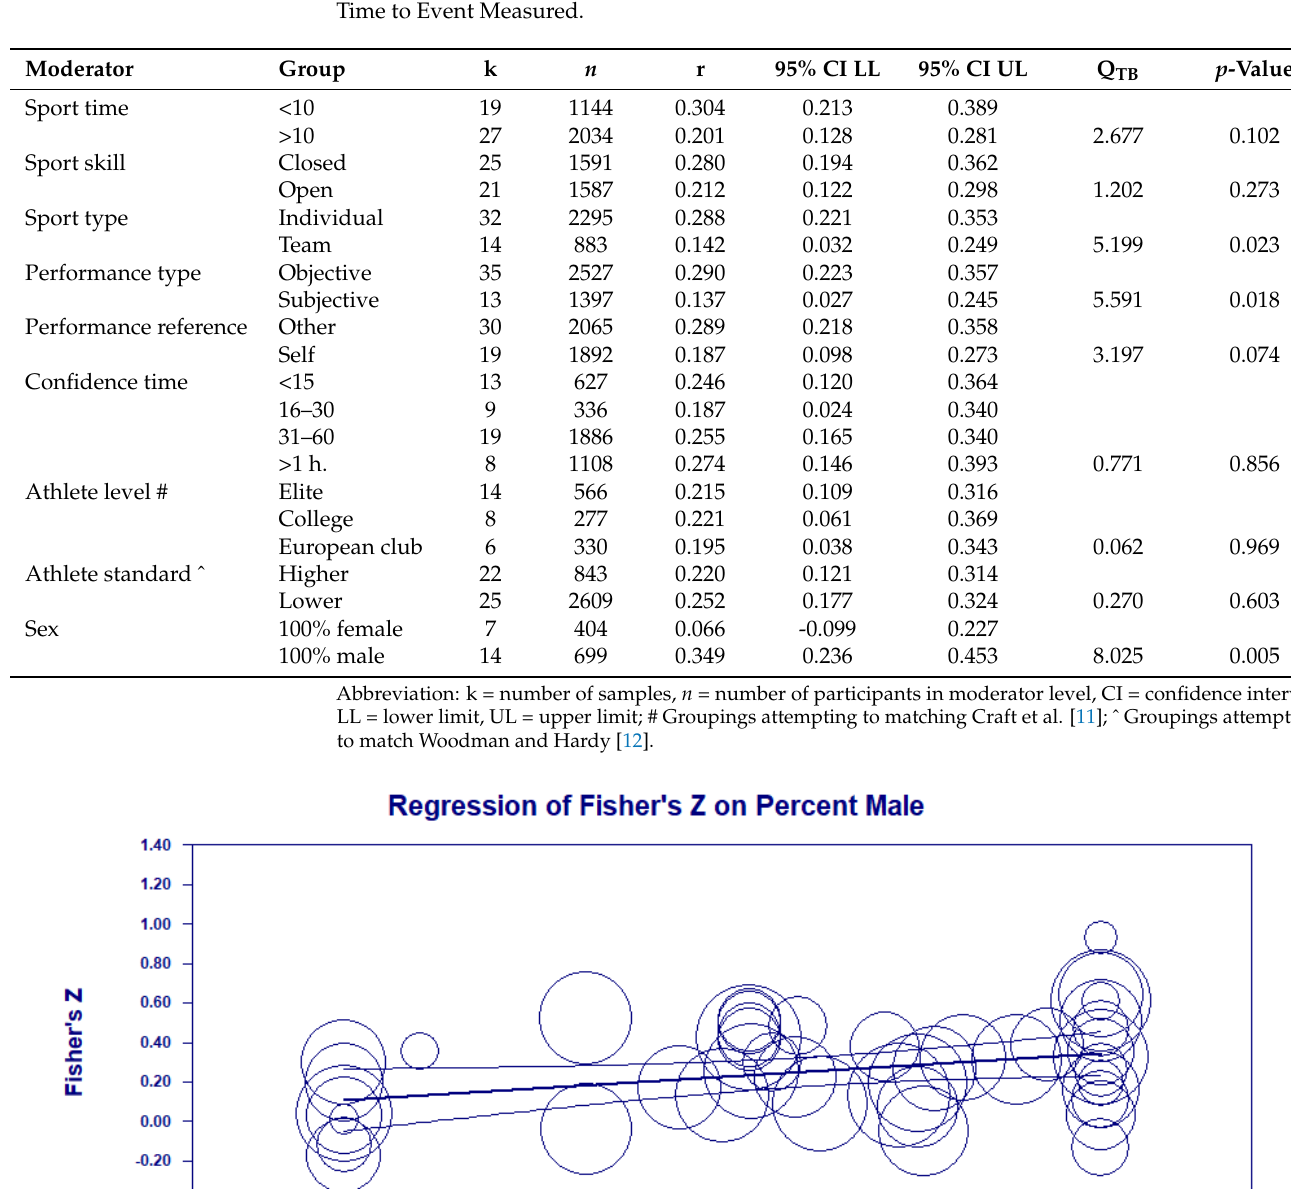
Table 4. Moderator Results for Terry’s Proposition, Performance Characteristics, and Confidence Time to Event Measured.